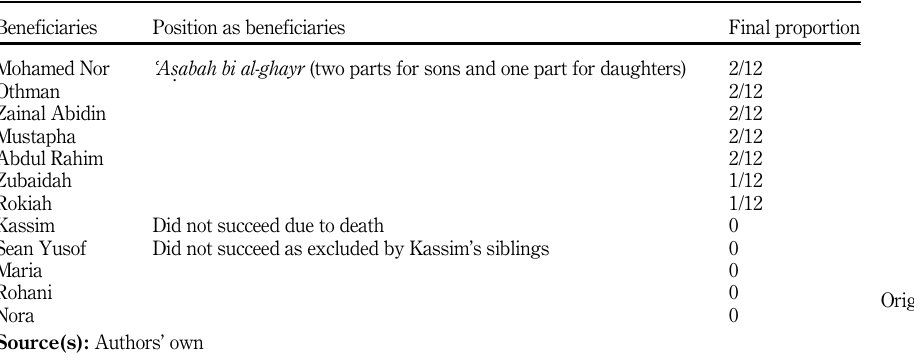
Table 3. Original calculation